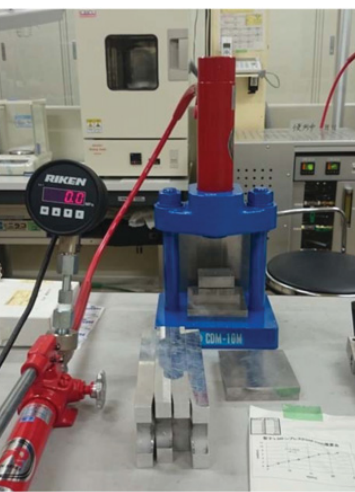
Figure 5. Hydraulic press used for preparation of the packed DNP sample.